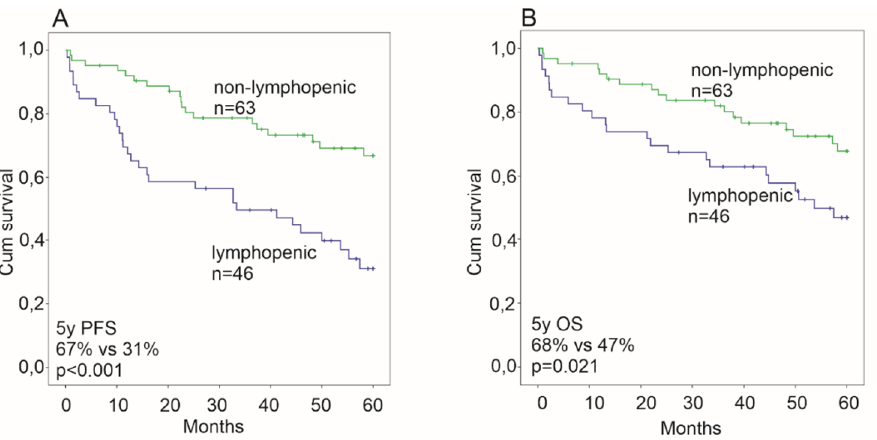
Figure 1. Kaplan-Meier survival estimates of the impact of lymphopenia on survival among rituximab treated patients for progression free survival (PFS, A ) and overall survival (OS, B ). Lymphopenia predicts an inferior survival for both OS and PFS. Table 3. Cox regression analyses on the multivariate level of rituximab treated patients showing an independent association of baseline characteristics and treatment parameters with the outcome.